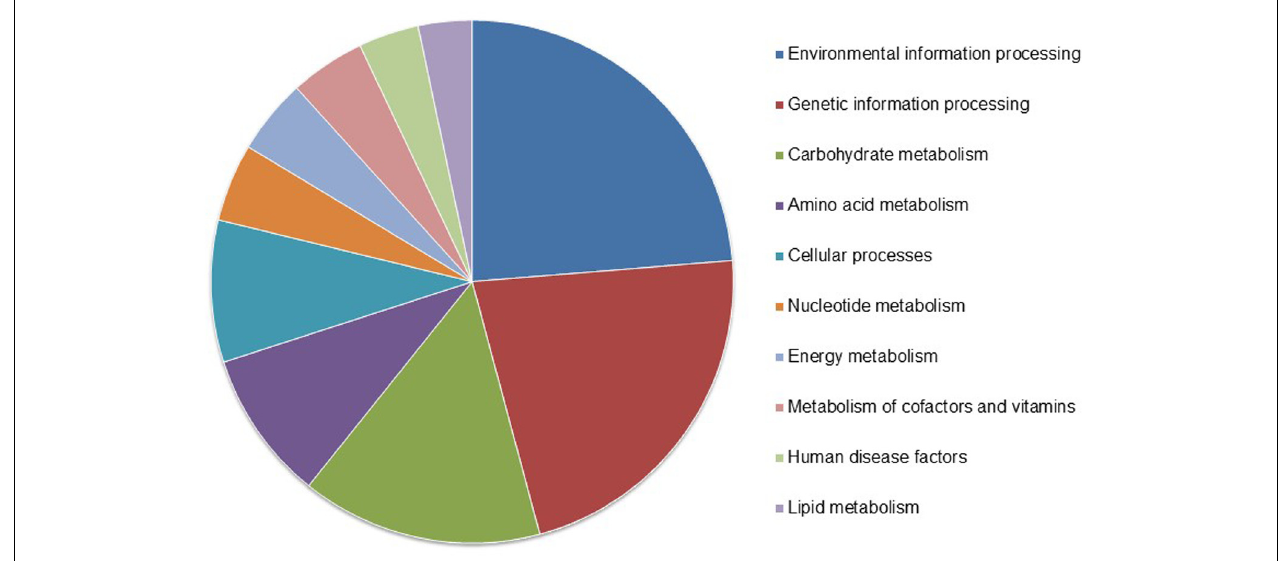
FIGURE 1 | BlastKOALA results of functional categories predicted in Lactobacillus pentosus MP-10 genome and their frequencies.